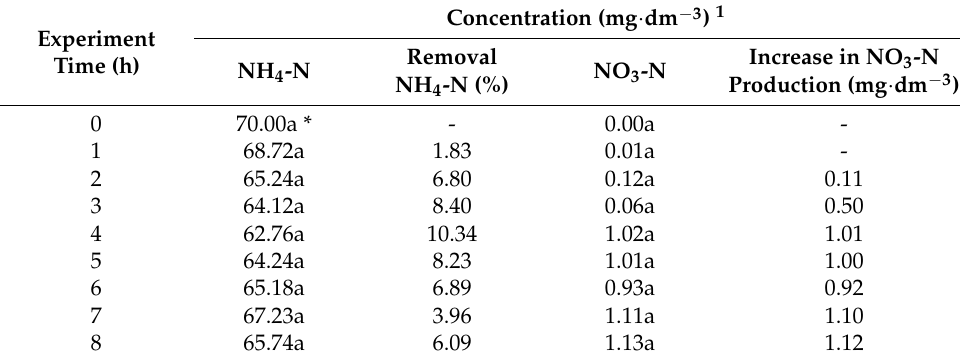
Table 4. The effect of ammonium nitrogen at a concentration of 70 mg · dm − 3 on the activity of nitrifying bacteria—dynamic